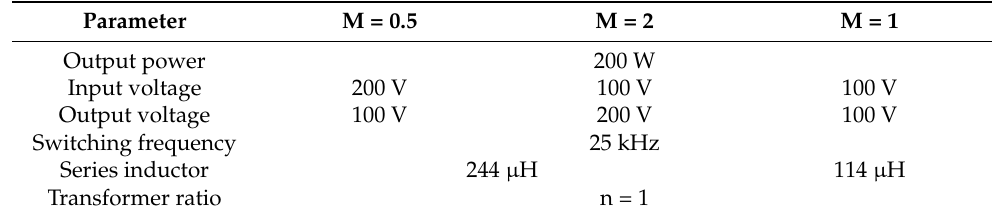
Table 5. Experimental test